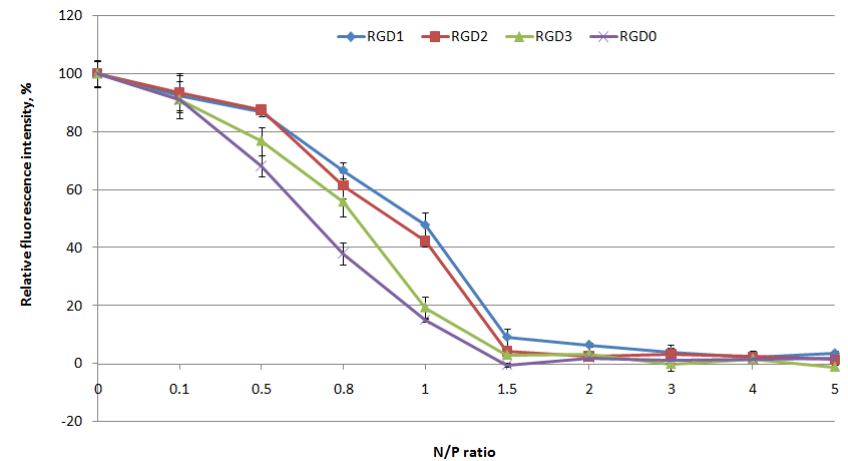
Figure 1. DNA binding studies by ethidium bromide (EtBr) exclusion from complexes of DNA and Arg-Gly-Asp (RGD)1, RGD2, RGD3 and RGD0 carriers. Values are the mean ± SD of the mean of triplicate experiments.